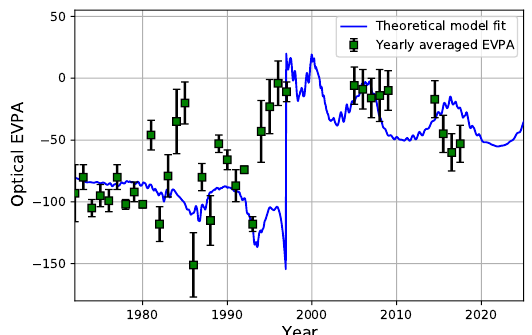
Figure 10. The annually averaged optical position angles of OJ 287 (points) together with the same jet model as in the radio jet observations. Note that the position angle has large fluctuations after the time of large optical flares, 1983/84 and 1994/95. The model parameters are the same as for the radio flares, except that time delay is 0.92 years, that is, the optical emission region is closer to the center than the observed radio jet region at 86 GHz. This region cannot be resolved in optical